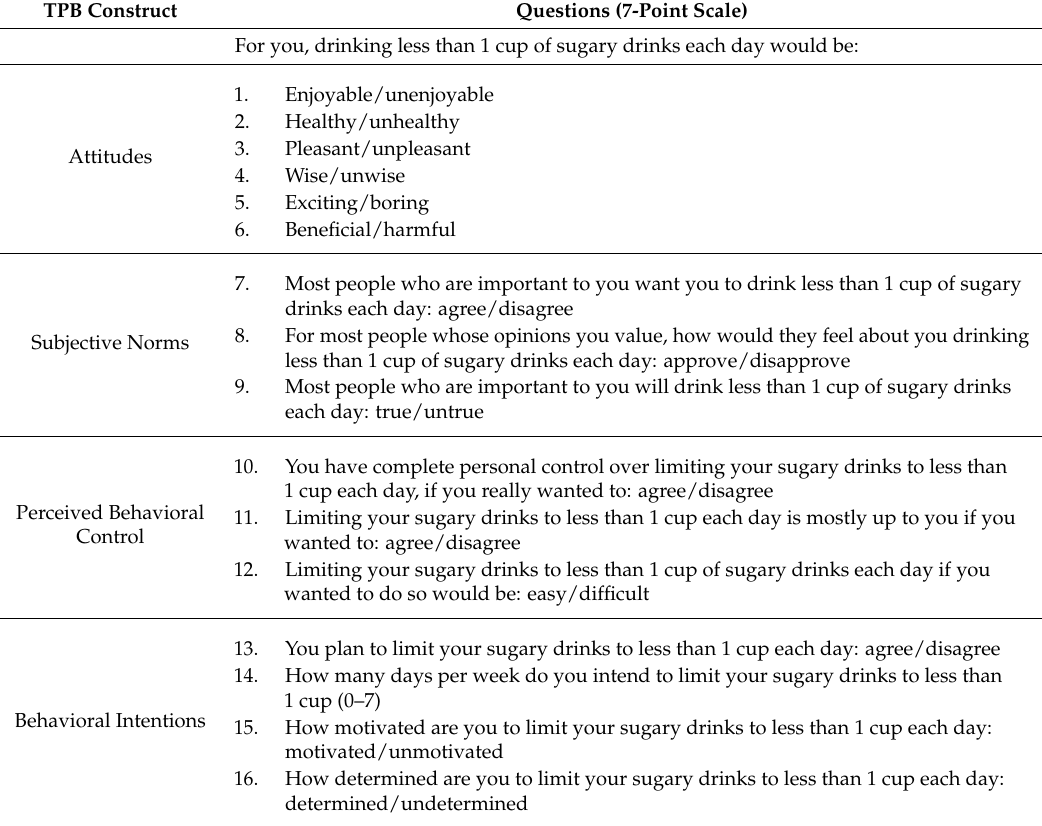
Theory of Planned Behavior (TPB) construct questions regarding sugar-sweetened beverage